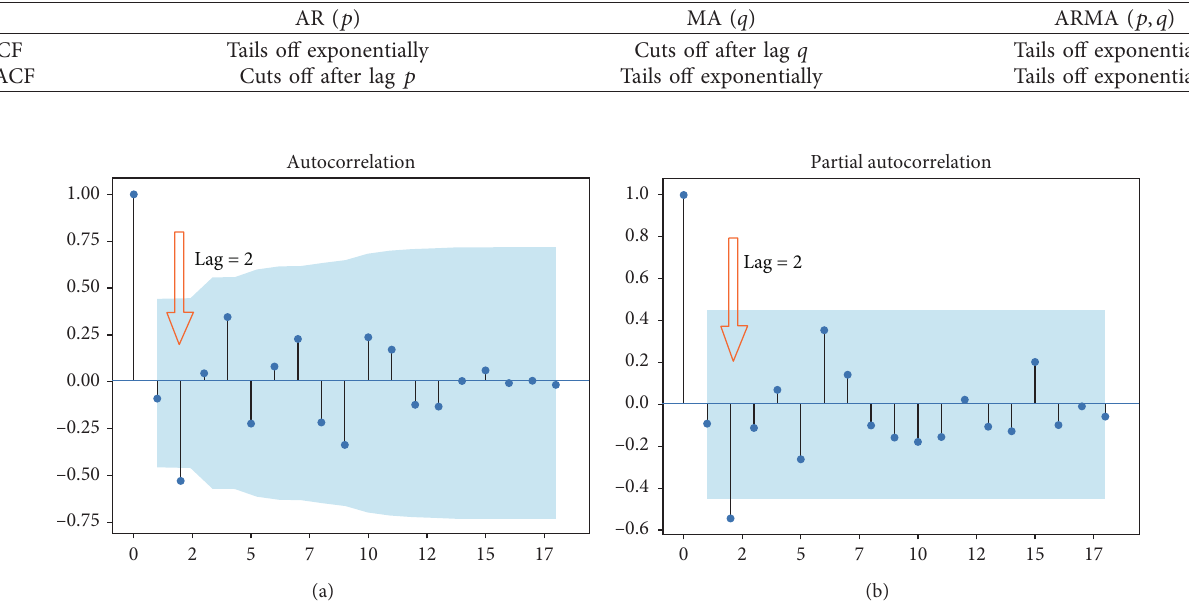
Table 3: ACF and PACF of the time series model.